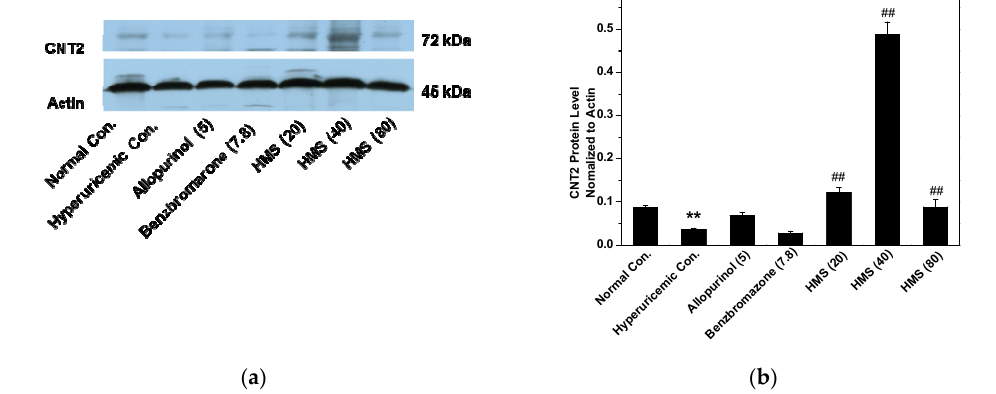
Figure 9. CNT2 protein levels in gastrointestinal tract: ( a ) Western blot bands; ( b ) the contents determined through densitometry and normalized to actin. Data were expressed as mean ± SD; n = 3. Statistical analysis by one-way ANOVA followed by two-tailed Student’s t -test; ** p < 0.01 versus the normal control; ## p < 0.01 versus hyperuricemic control.